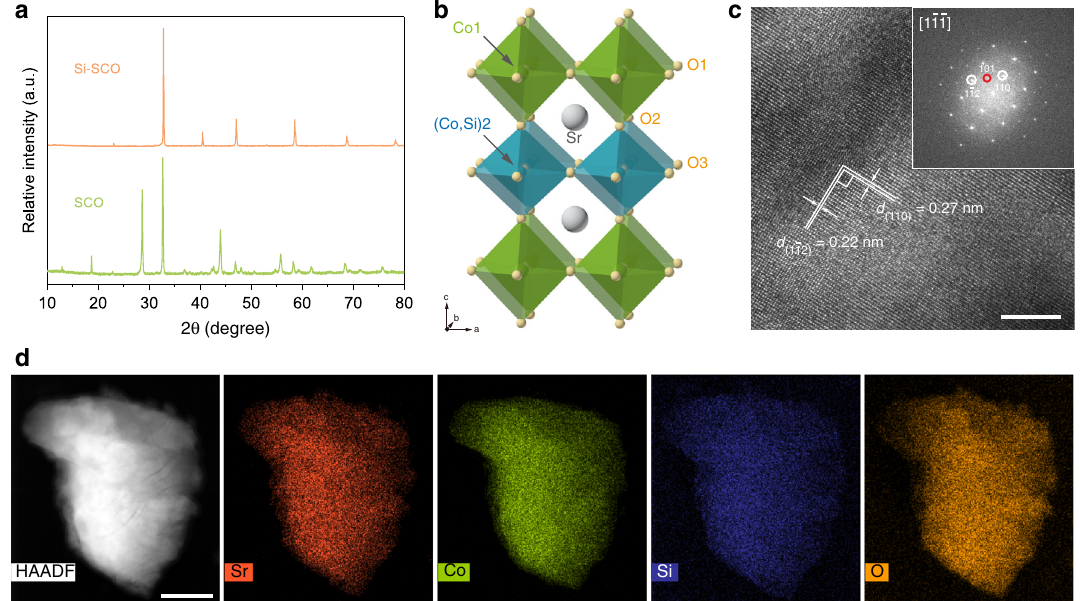
Fig. 1 Structural characterisations of Si-incorporated strontium cobaltites. a XRD patterns showing the formation of a tetragonal phase upon the incorporation of Si into SCO. b A schematic depicting the tetragonal crystal structure of Si – SCO. c HRTEM image of Si – SCO and the corresponding FFT pattern with zone axis of [1 (cid:1) 1 (cid:1) 1]. d HAADF-STEM image of Si – SCO and the corresponding EDS mapping images of Sr, Co, Si and O. Scale bar in c is 5 nm and in d is 200